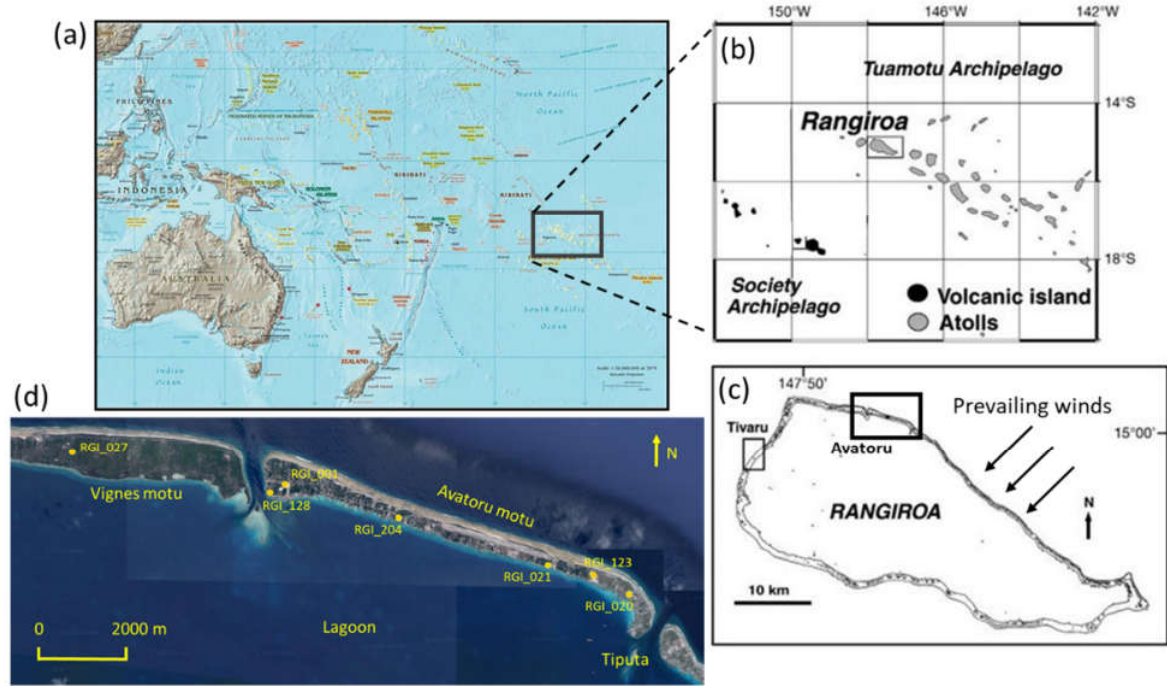
Figure 1. Location of Rangiroa atoll island; ( a ) Pacific ocean map; ( b ) Tuamoto archipelago ( c ) Rangiroa island; ( d ) location of RGI_xxx wells on Avatoru and Vignes motus.